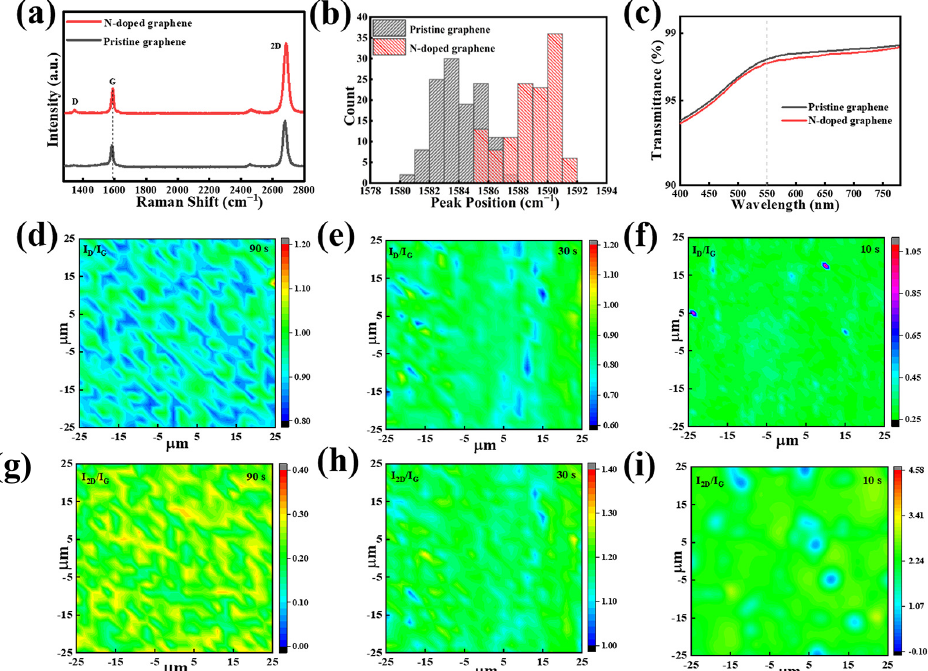
Figure 3. ( a ) Raman spectra of the NG films and pristine graphene films. ( b ) Distribution chart of Raman G-peak position of pristine graphene and NG films. ( c ) The transmittance of the pristine graphene and NG films. Spatial maps of ( d – f ) I D /I G and ( g – i ) I 2D /I G of the NG films using condensa- tion treatment starting at 90 s, 30 s, and 10 s after the end of growth, respectively. D and G represent the peaks of the curve.